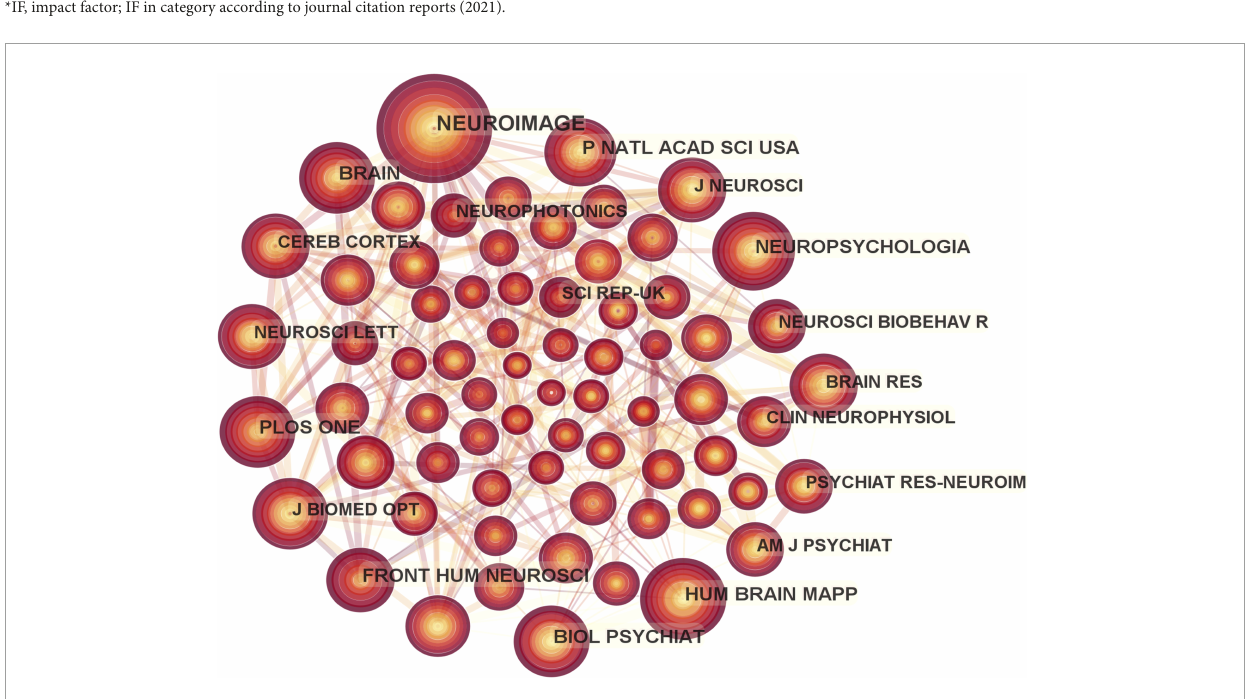
cortex, #7 motor control, #8 cue reactivity, and #9 multimodal neuroimaging. The main clusters and their keywords are shown in Table 3